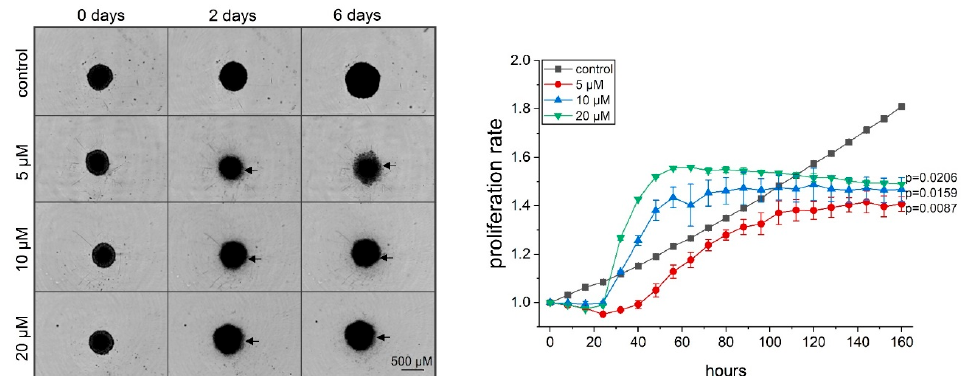
Figure 4. ThioA inhibits proliferation in 3D cell culture. 3-day old HCT116 tumor spheroids were treated with thioA, and the spheroid area was analyzed by automated microscopy (right panel). Treatment with thioA led to a disrupted spheroid structure, as seen by a detachment of cells from the core (arrows, left panel), causing an initial spheroid area increase. Spheroids are shown in representative pictures at the starting point and the time points 2 days and 6 days after treatment (left panel). Statistical analysis was performed for the last acquired time point using one-way ANOVA followed by Bonferroni’s post-hoc analysis. n = 2 (quadruplicates).